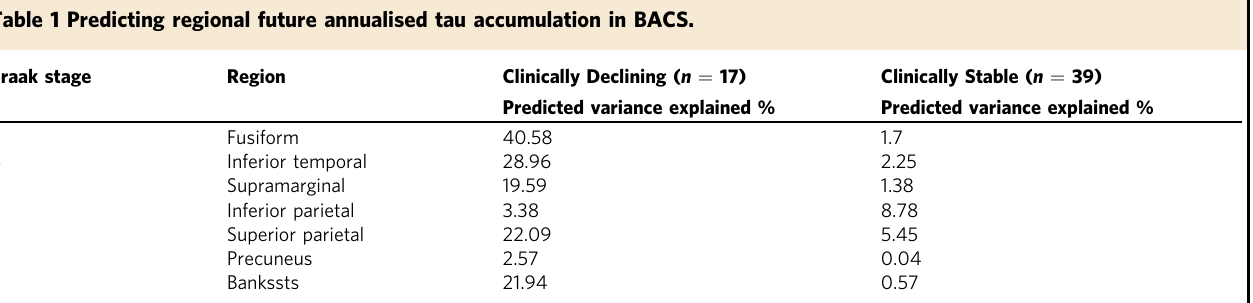
Shared variance of the predicted regional future tau accumulation and the observed future tau accumulation for individuals from the BACS cohort classi fi ed as Clinically Stable or Clinically Declining. Source data are provided as a Source Data fi